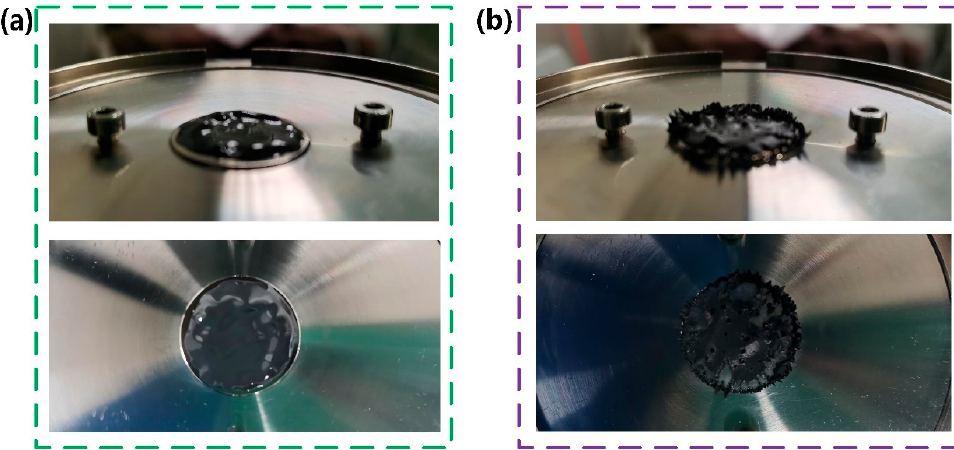
Figure 1. Photos of MRG-70 under 0 kA/m ( a ) and 293 kA/m ( b ) magnetic field strength.